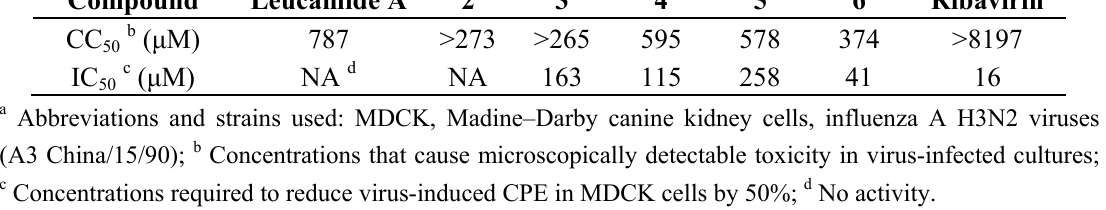
Table 1. Anti-influenza A virus activity and cytotoxicity of leucamide A and its analogues in MDCK a .